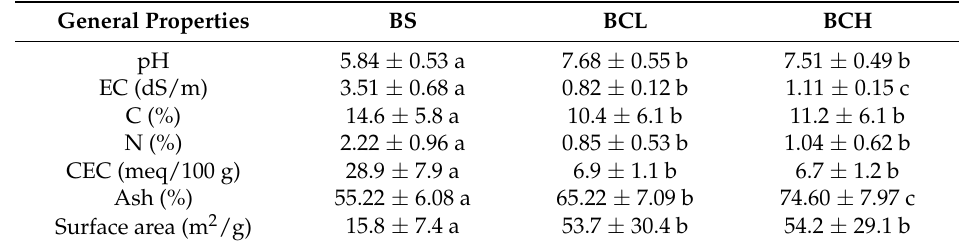
Table 3. General properties of the biosolids and corresponding biochar samples. BS: biosolids, BCL: biochars prepared at low temperature, BCH: biochars prepared at high temperature. Different letters within the same row represent significant differences in the mean values.